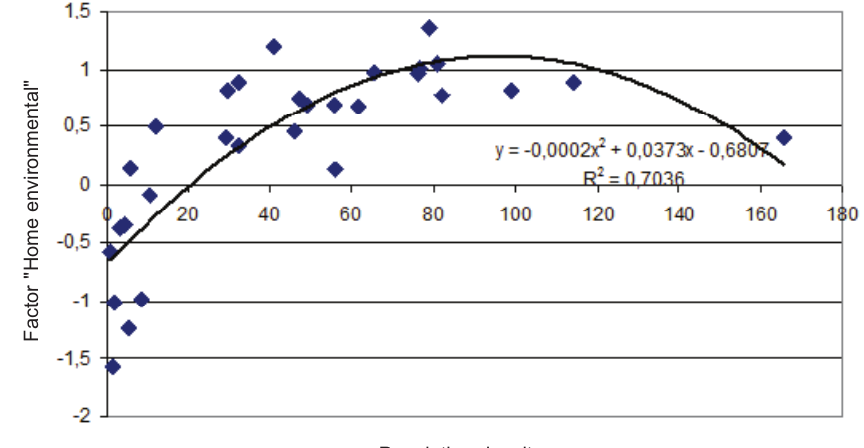
figure 6. relation between population density in districts and the factor of home